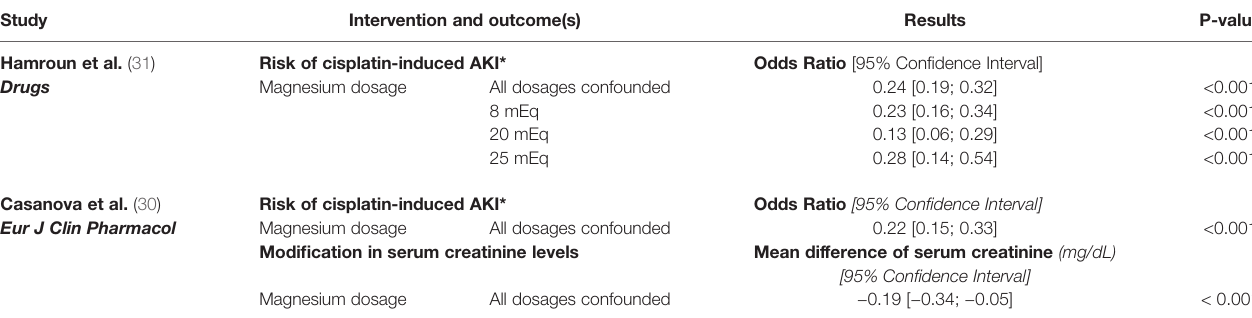
TABLE 1 | Published results on the association between cisplatin-induced AKI* and magnesium administration.